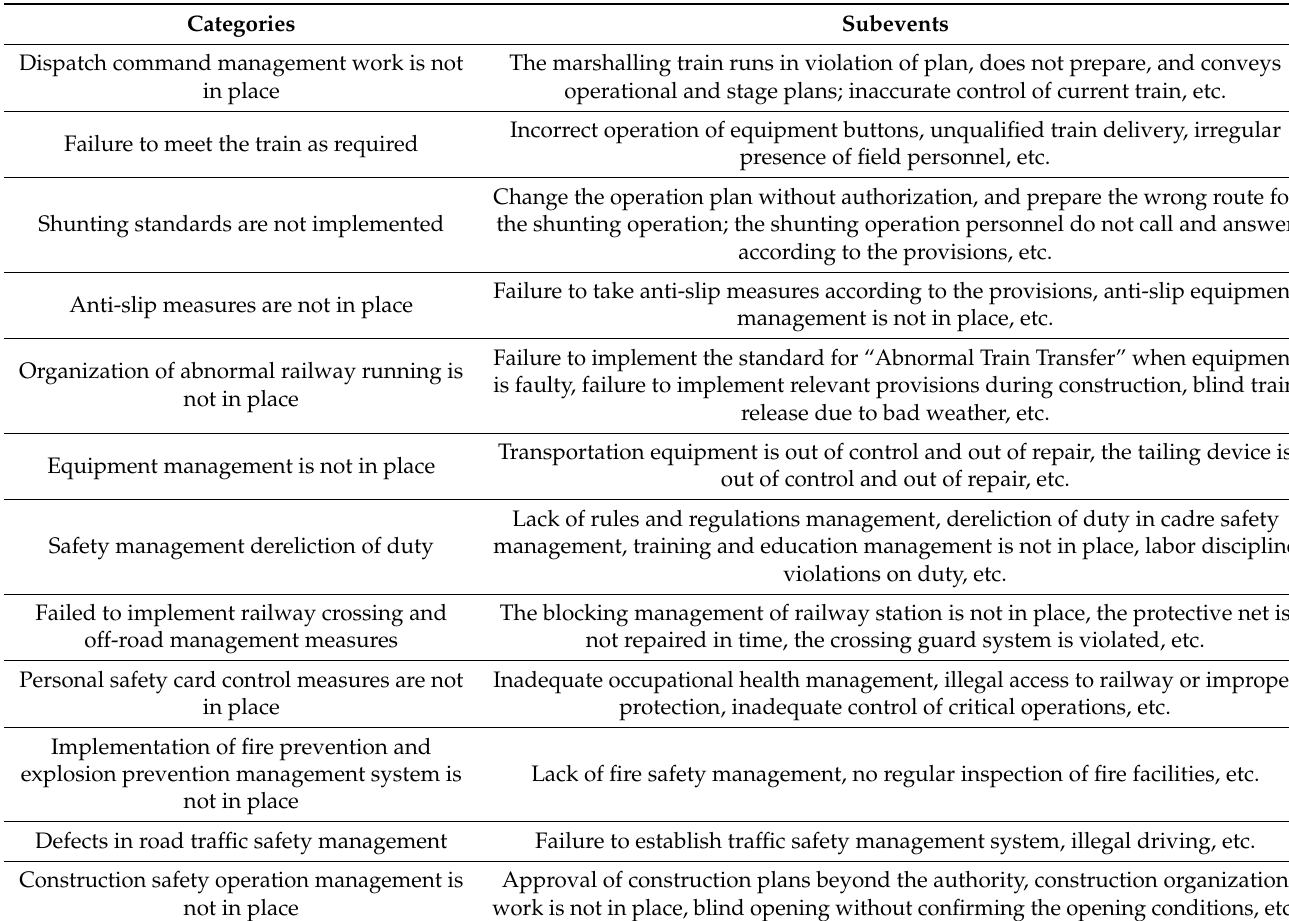
Table 3. Classification of grid events in the train operation